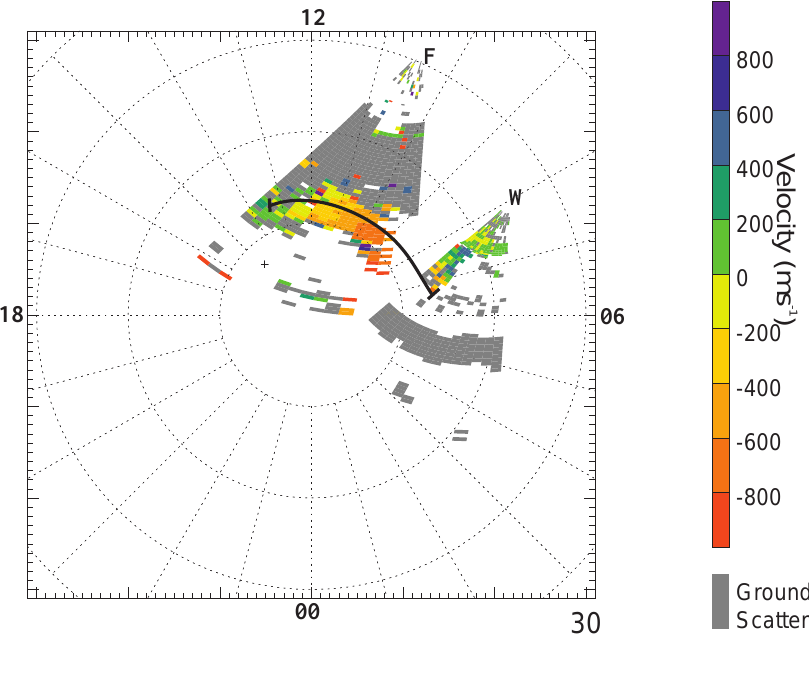
Fig. 9. Polar plot of the l-o-s veloc- ity for the Hankasalmi and Iceland West radars for 08:10UT. The overlaid black line shows the estimated extent of the merging gap